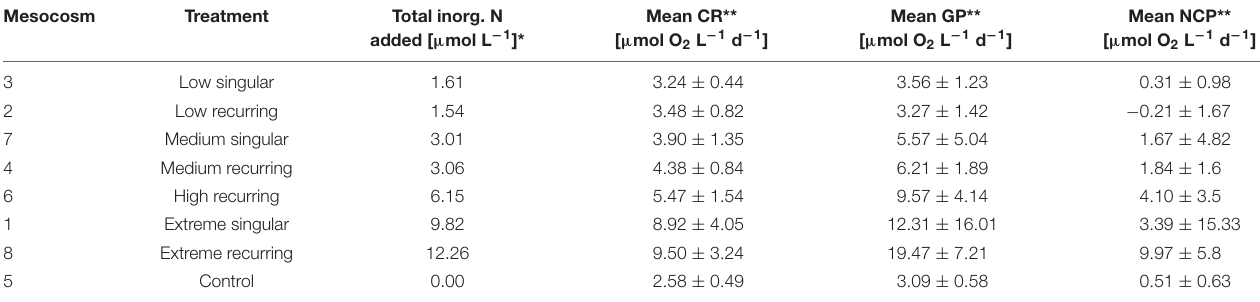
TABLE 1 | Treatment overview with mesocosm volumes, total nutrients added and mean CR/GP/NCP rates with standard deviations for the duration of the study. Mesocosm